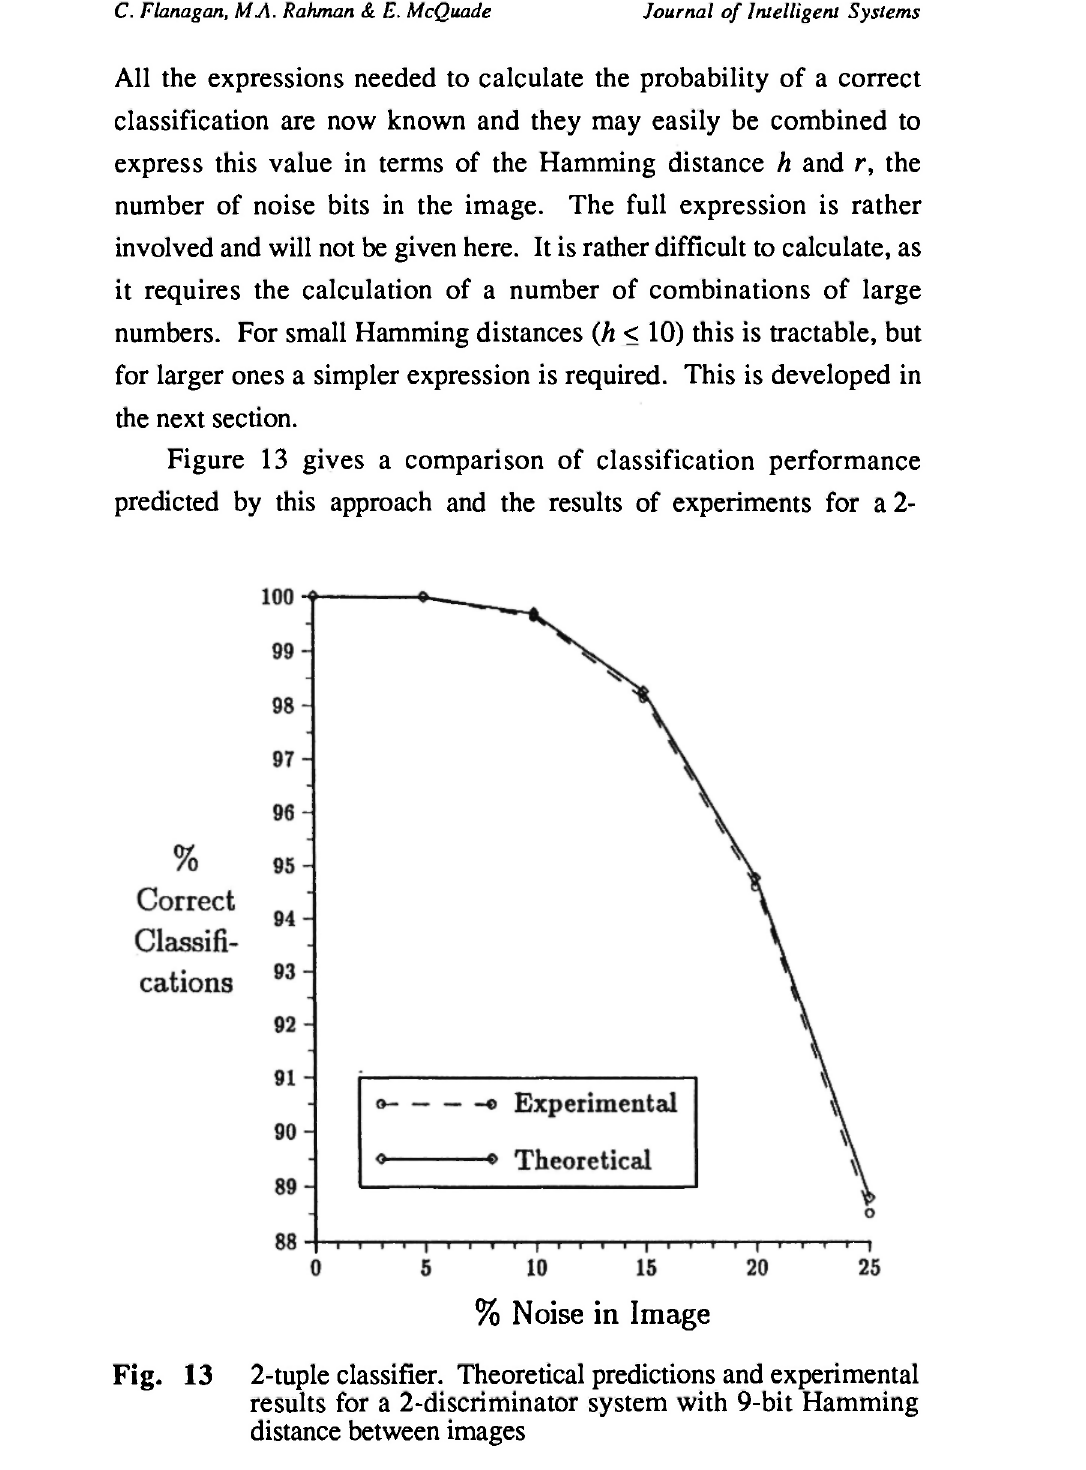
Fig. 13 2-tuple classifier. Theoretical predictions and experimental results for a 2-discriminator system with 9-bit Hamming distance between images